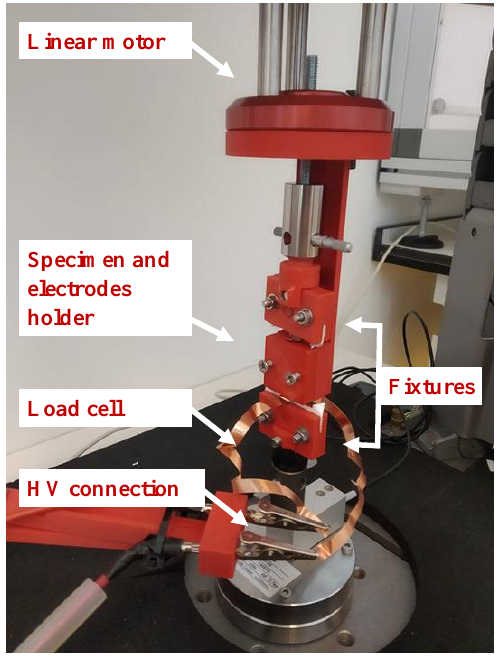
Figure 3. Specimen in the Instron test instrument. The fixtures and the support for the specimen (zoomed in the figure) are rigidly connected to the linear motor at the top. The contraction force of the specimen is registered by the Instron load cell placed at the bottom.